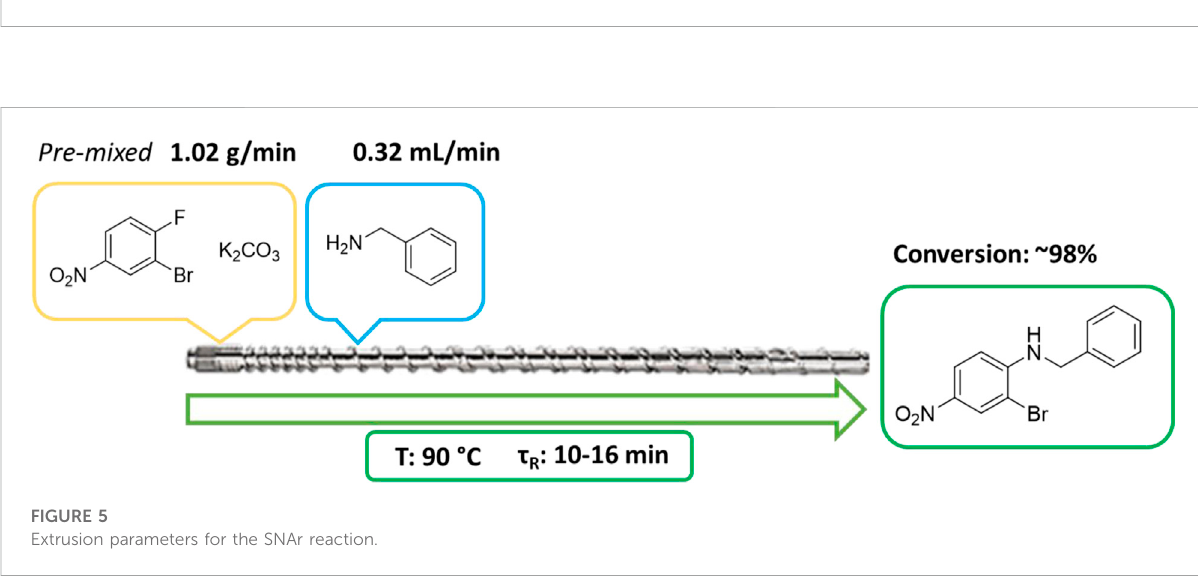
FIGURE 4 Process mass intensity (PMI), quantity of wastewater and cost for the gate-to-gate production of 1 kg of nitrofurantoin by TSE (left, yellow) and conventional solvent-batch (right, green) synthesis routes (Authors ’ graphic inspired by Galant et al., 2022).